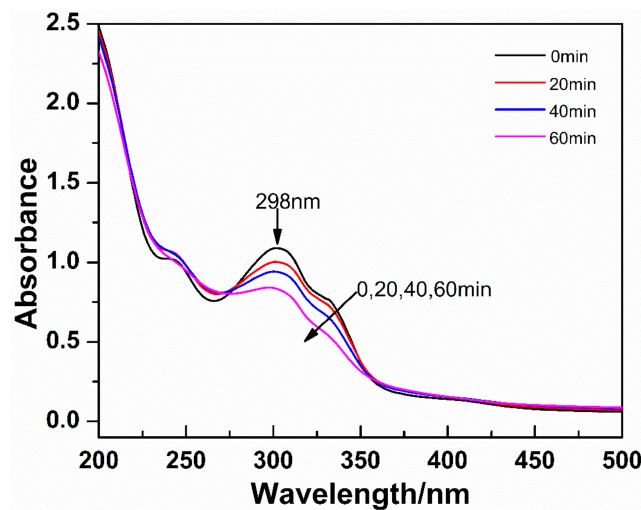
Figure 3. UV-Vis absorption spectra of the CaMn 7 O 12 gel film at di ff erent UV irradiation